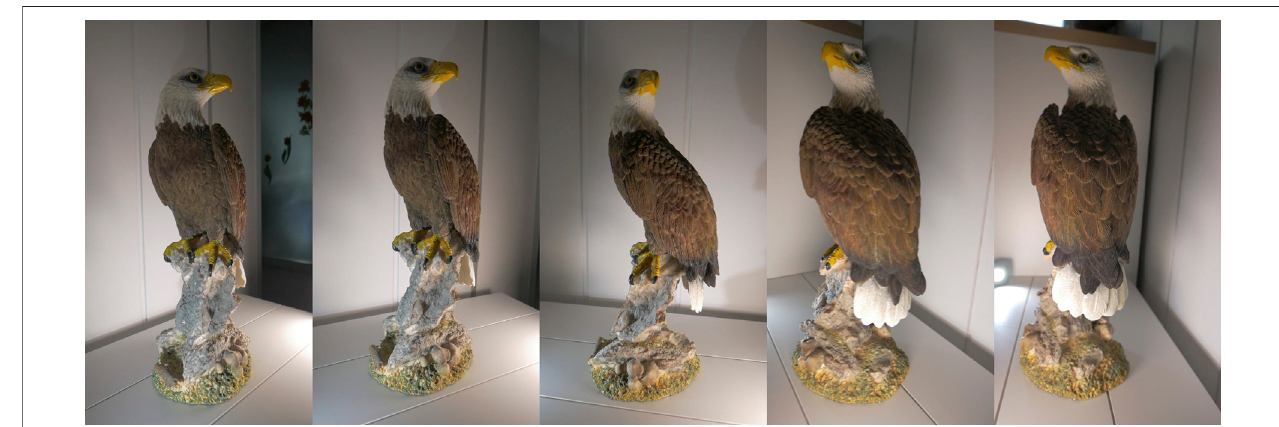
FIGURE 3 | Sample frames of the video used for the user